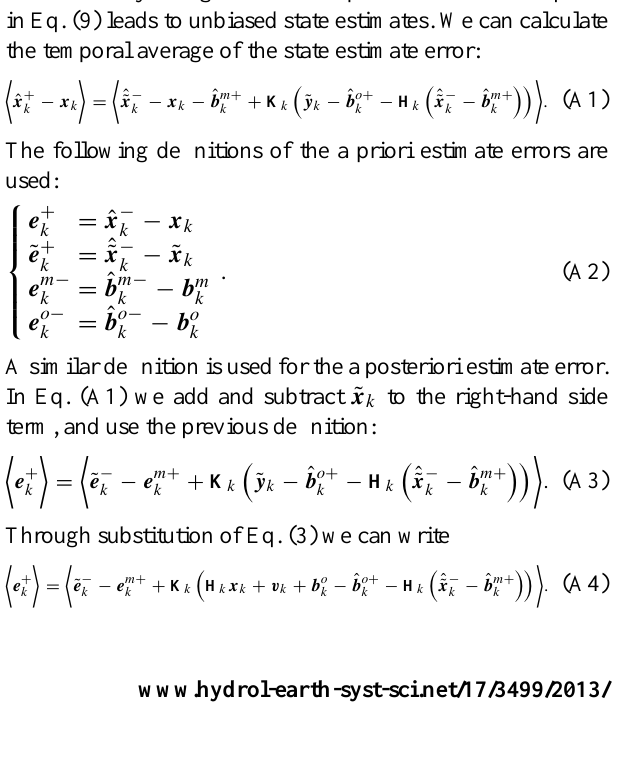
Fig. 11. Time series of the standard deviation of the a priori biased state error covariance (top three panels) and the a priori observa- tion bias error covariance (bottom panel) for the experiment with sinusoidal observation and forecast biases.